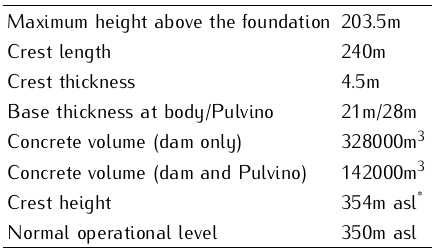
Table 1. Main characteristics of Dez arch dam Maximum height above the foundation 203.5m Crest length